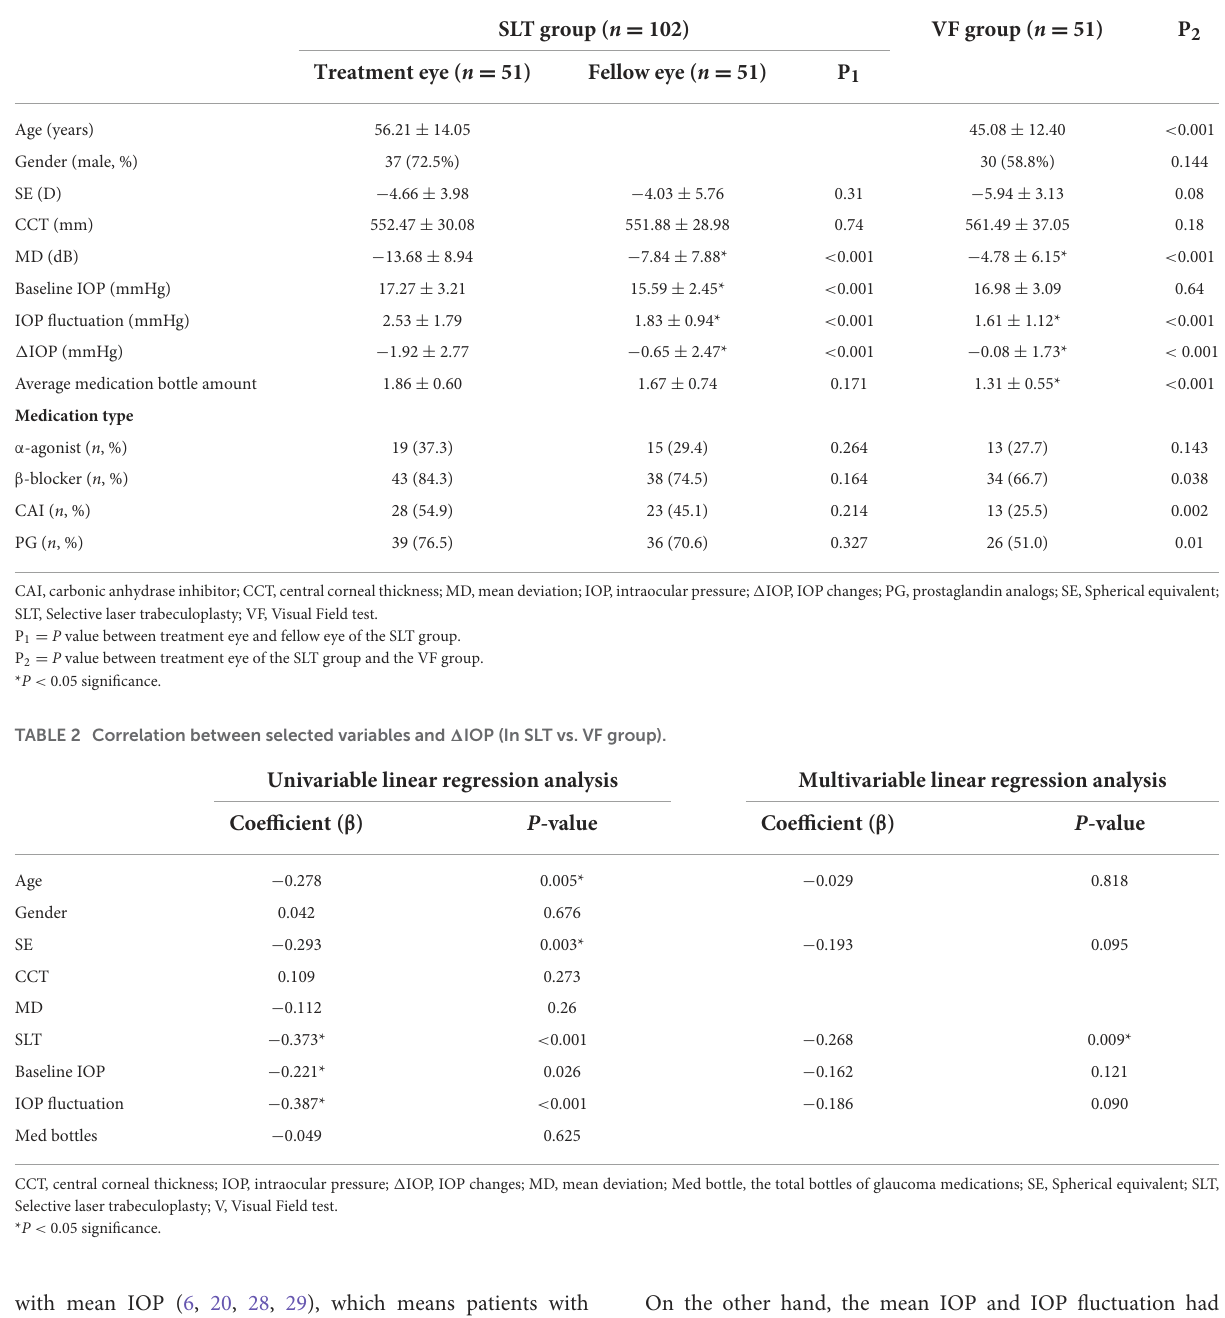
TABLE 1 Patients’ characteristics in the SLT and VF group.